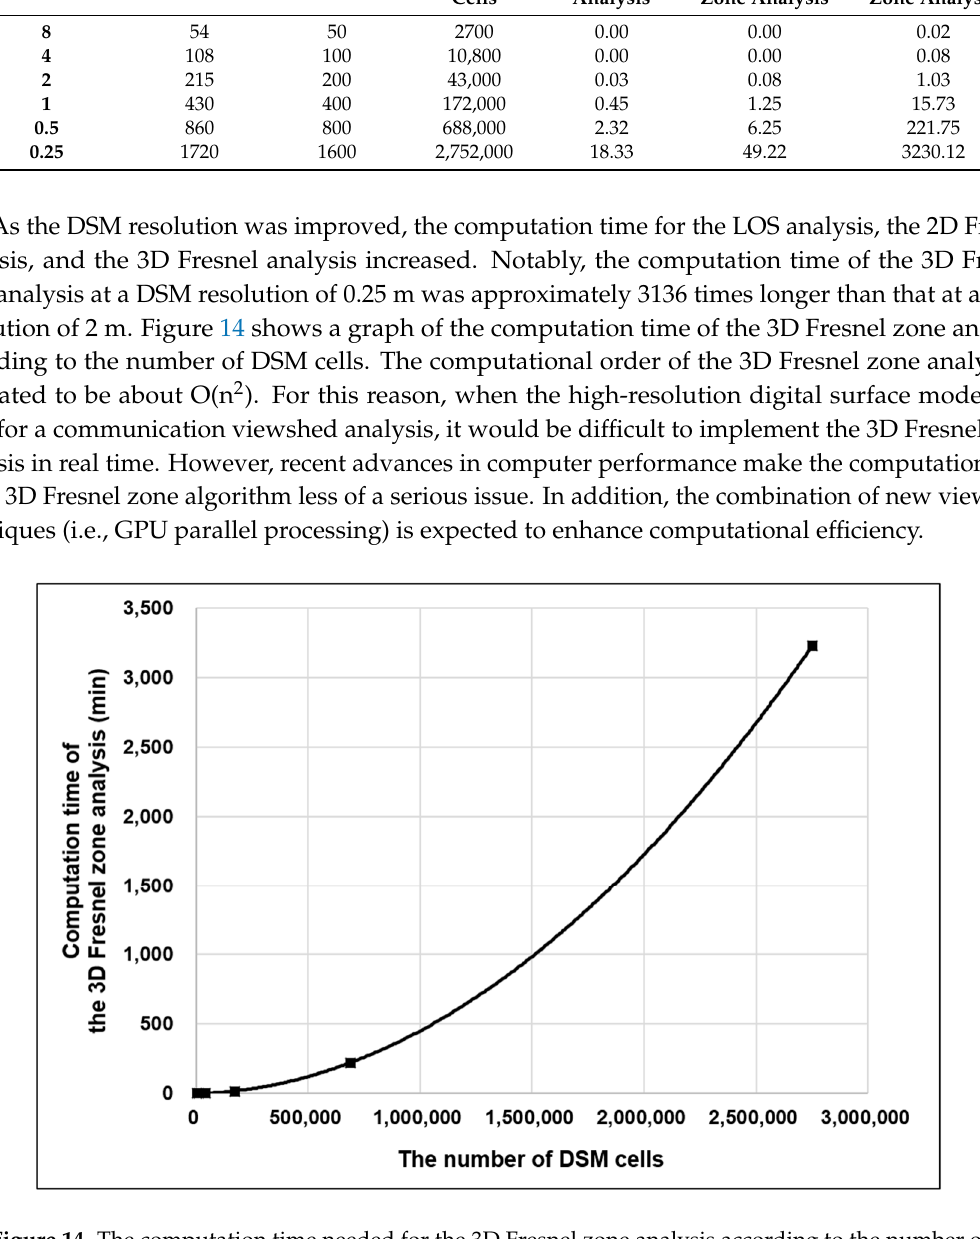
Figure 14. The computation time needed for the 3D Fresnel zone analysis according to the number of DSM cells.